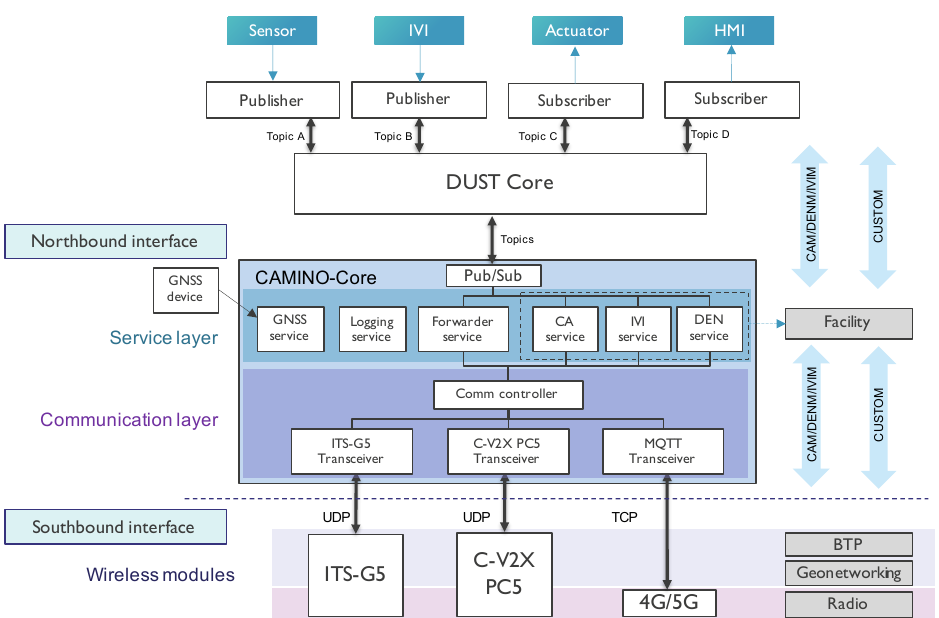
Figure 2. Overall CAMINO framework